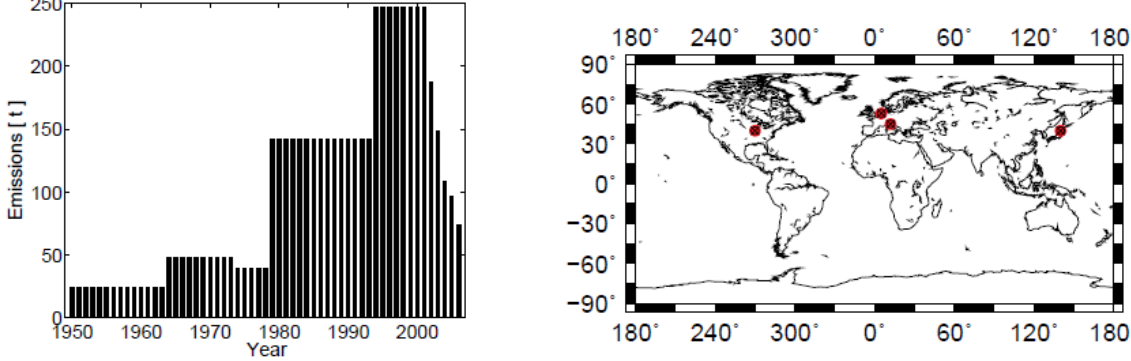
Fig. 1. PFOA emissions: temporal [ta − 1 ] and spatial distributions.